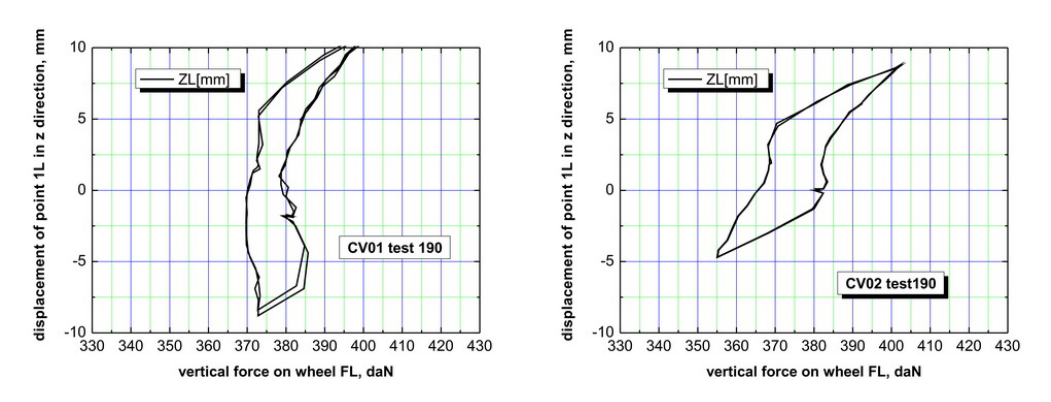
Fig. 5.9. Displacement alterations depending on vertical force during test No.190 – vehicle 01.